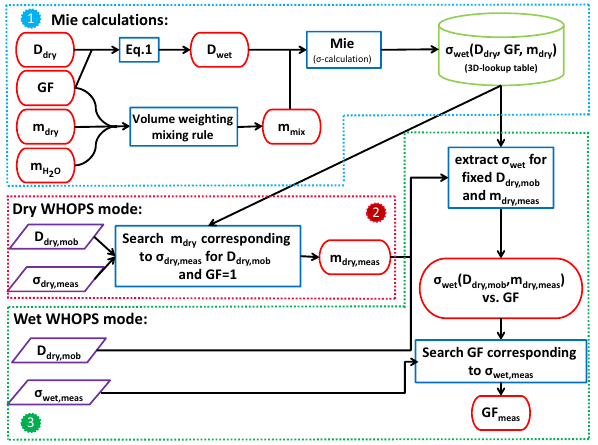
Figure 4. Calculated scattering cross section as a function of par- ticle diameter (hygroscopic growth factor) for solution droplets (green lines) formed on particles with a dry diameter of (a) 500nm and (b) 300nm. A volume weighting mixing rule is used to deter- mine the index of refraction of the solution droplet (see Sect. 2.2.2 = 1 . 333; and Fig. 3). The Mie curves for pure water droplets ( m H 2 O blue lines) and particles with a constant index of refraction, m dry = 1 . 45 (solid red lines) and m dry = 1 . 55 (dashed red lines), are also shown as a reference.